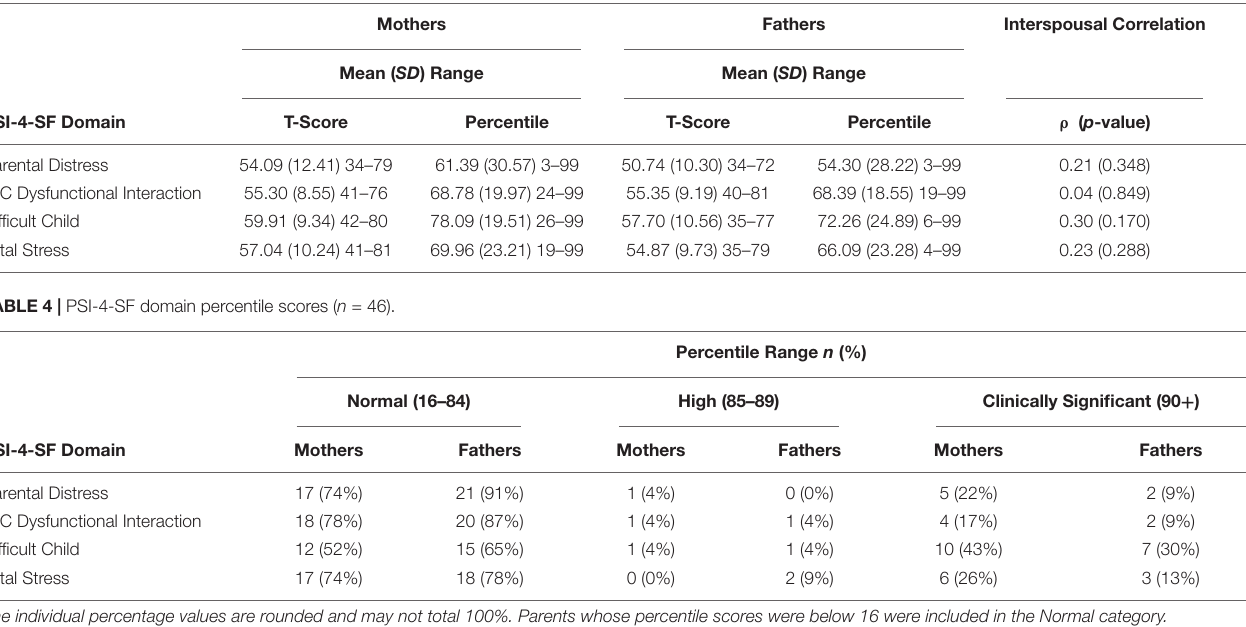
TABLE 3 | Mother-father comparisons of PSI-4-SF domain scores ( n = 46).